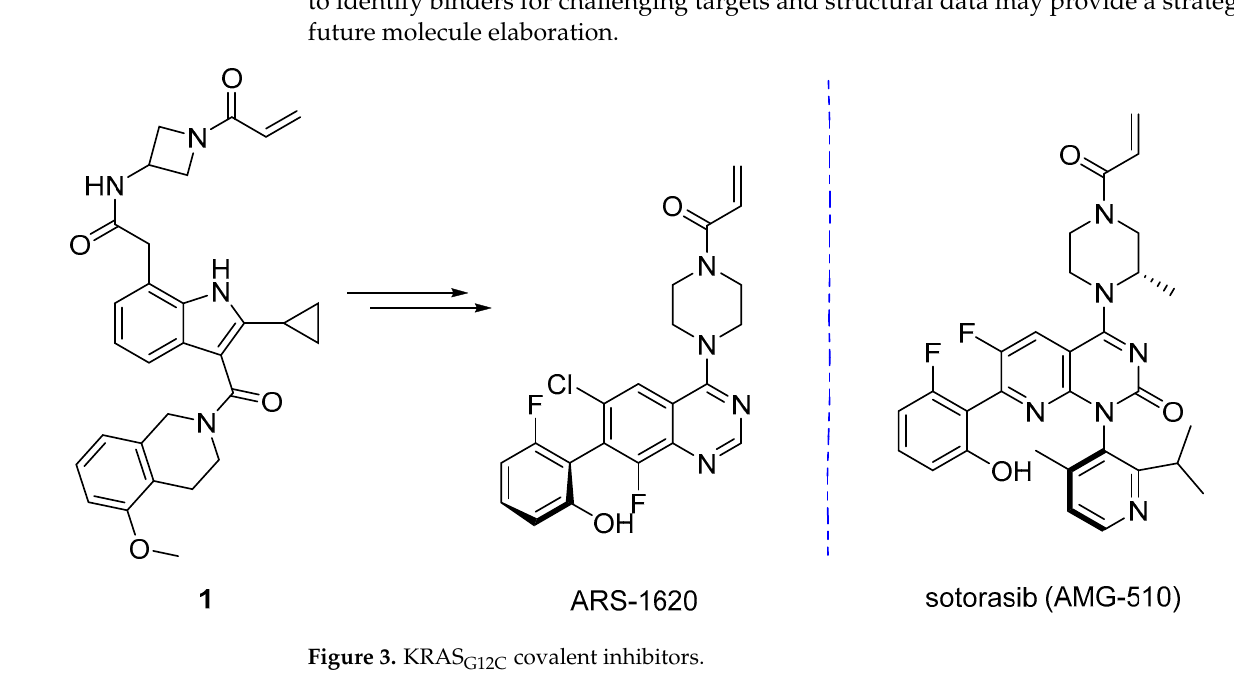
Figure 3. KRAS G12C covalent inhibitors.